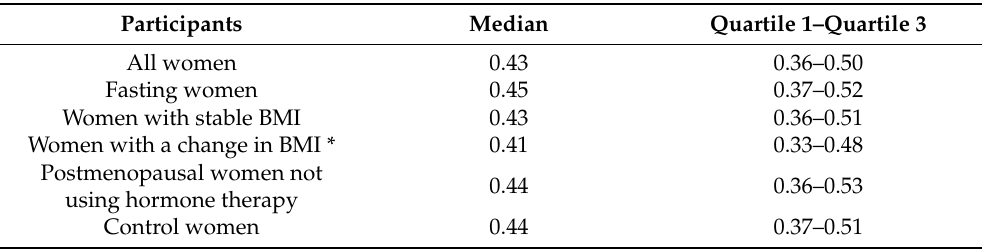
Table 2. Metabolomic profiles stability over 10 years for known metabolites ( n = 295). ICCs were estimated among all women ( n = 1880 of which 1184 donated 2 samples), fasting women ( n = 1309 of which 765 donated 2 samples), among women with stable BMI ( n = 706) or with a change in BMI ( n = 478 samples), postmenopausal women not using hormone therapy ( n = 577 of which 223 donated 2 samples), and control women ( n = 940 of which 592 donated 2 samples). The stable BMI group includes participants with ≤ 2 kg/m 2 change in BMI between the two blood collections. The groups with a change in BMI includes participants with >2 kg/m 2 change in BMI between the two blood collections. Participants Median Quartile 1–Quartile